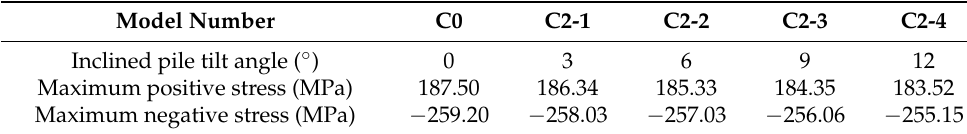
Table 10. Model C2 parameter